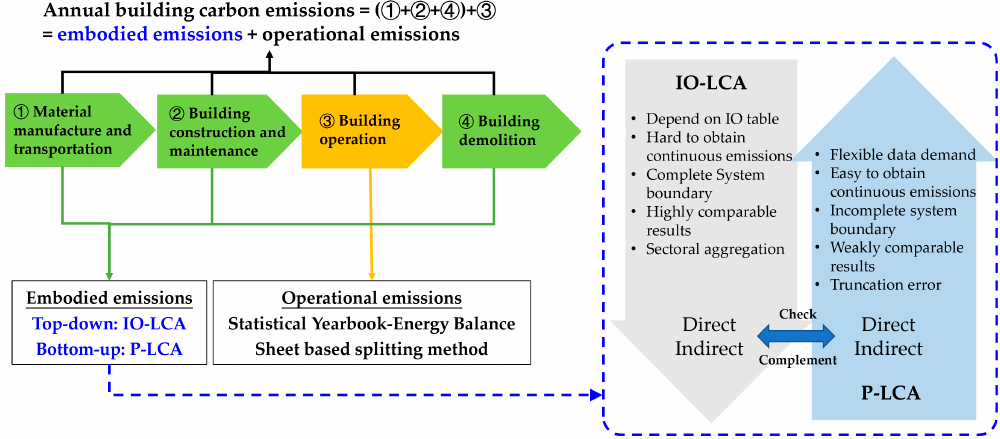
Figure 4. Annual total carbon emission accounting model for China’s building sector.